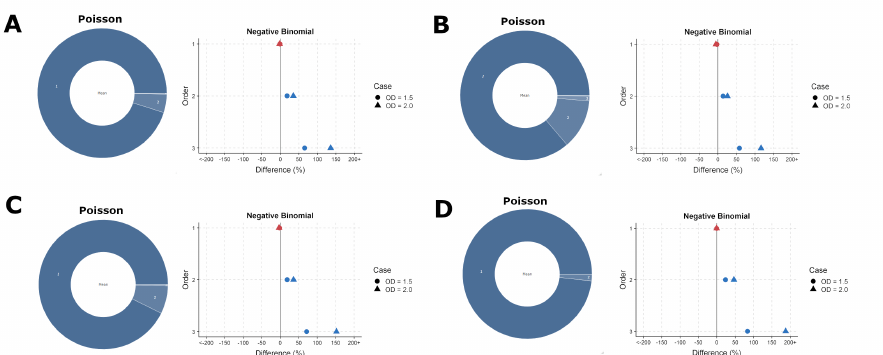
Figure 12. ( Panels A – D ) depict post-catXL AAL decomposition results for the 1–2, 2–5, 10–20 and 50–100 year return period layers. The over-dispersive sensitivity models are depicted by the x-y plots which give the percent change over for contributions up to order M = 3 relative to the baseline Poisson